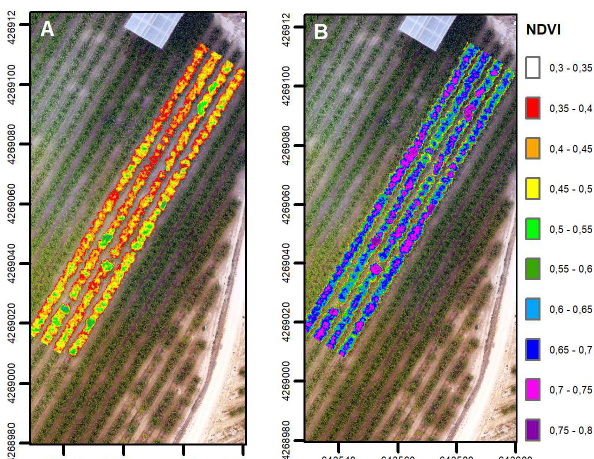
Figure 2 . Normalized difference vegetation index (NDVI) distribution map of the sweet cherry Figure 2. Normalized di ff erence vegetation index (NDVI) distribution map of the sweet cherry orchard orchard in 2017 preharvest ( A ) and postharvest ( B ). in 2017 preharvest ( A ) and postharvest ( B